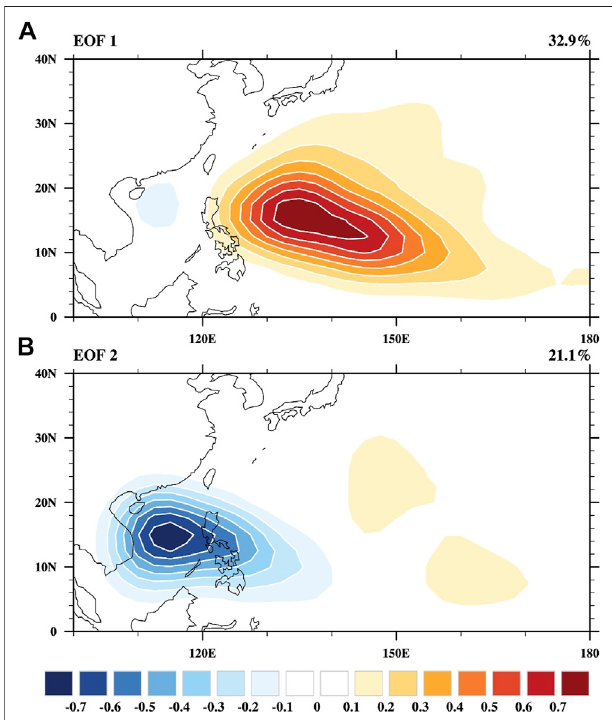
FIGURE 1 | The (A) fi rst and (B) second EOF mode of TC track frequency in the late-season during 1965 – 2018. The percentage of variances explained by the EOF modes are shown on the